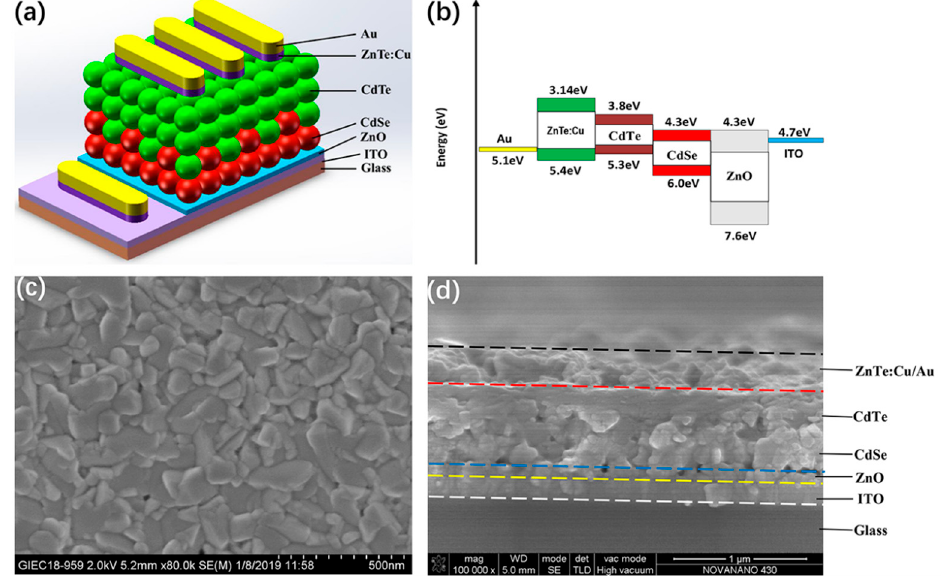
Figure 3. ( a ) Schematic of nanocrystal (NC) solar cells with a structure of ITO/ZnO/CdSe/CdTe/ZnTe:Cu/Au; ( b ) band alignment of ITO, ZnO, CdSe, CdTe, ZnTe:Cu, and Au; ( c ) SEM images of CdTe NC thin film; ( d ) cross-section SEM images of ITO/ZnO/CdSe/CdTe/ZnTe:Cu/Au.